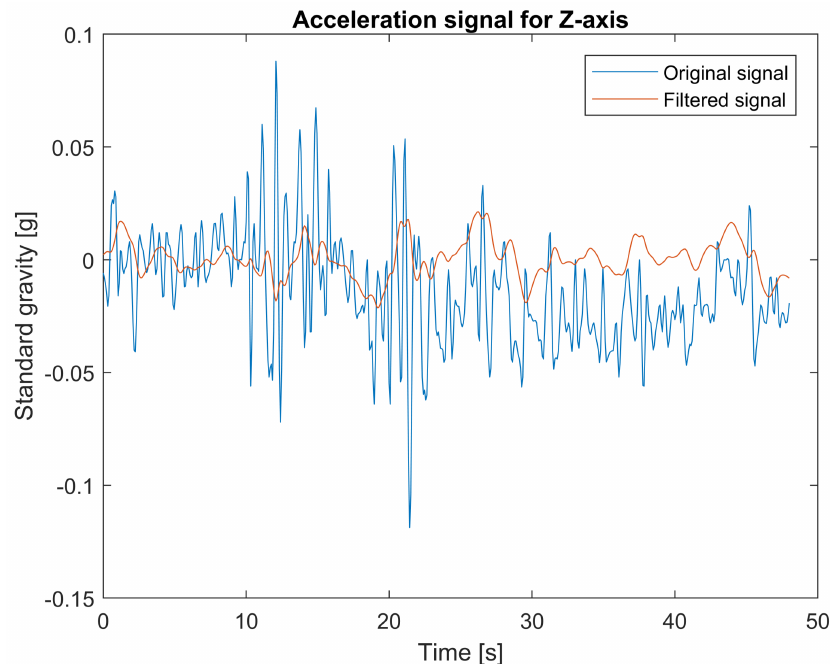
Figure 5. Original and filtered acceleration signal for z -axis.